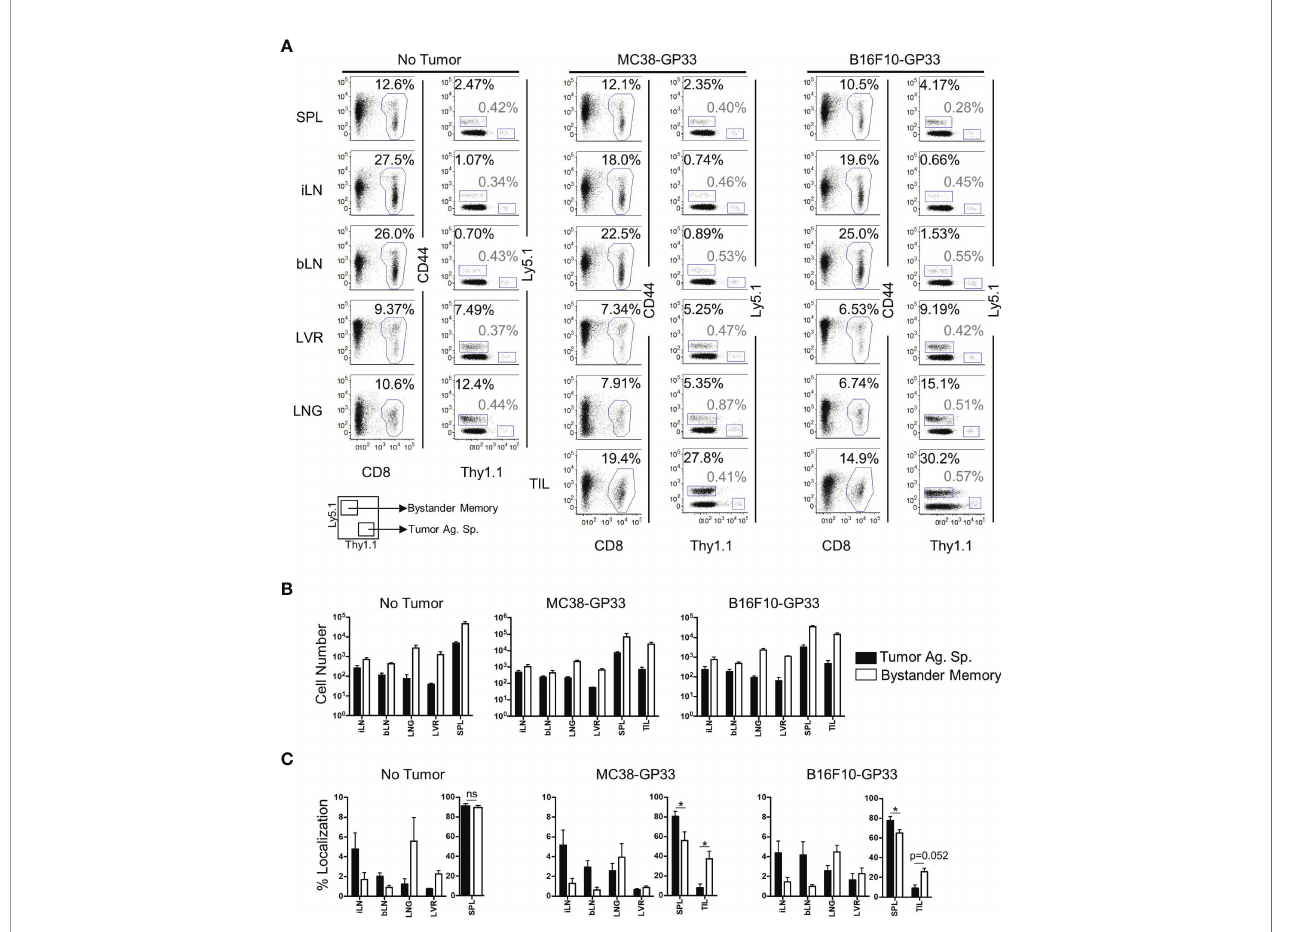
FIGURE 1 | Bystander Memory T Cells in fi ltrate into established solid tumors. WT OT-I CD8 T cells were adoptively transferred into C57BL6 mice and infected with LM-Ova. Following memory differentiation (>day 30 post infection), naïve P14 CD8 T cells were transferred into the mice. The mice were then subcutaneously injected with MC38-GP33 or B16.F10-GP33 tumor cells. (A) FACS plots of CD8 T cells in spleen (SPL), brachial lymph node (bLN), inguinal lymph node, (iLN), liver (LVR), lung (LNG), and tumor in fi ltrating lymphocytes (TIL) show the frequency of donor CD8 T cells of total CD8 T cells or the frequency of bystander memory OT-I donors (black) and tumor antigen speci fi c P14 donors (gray) of total CD8 T cells at day 21 post tumor injection. Bar graphs show (B) the total number of CD8 T cells, bystander memory, and tumor antigen speci fi c T cells in each tissue and (C) the percent localization of bystander memory cells and tumor antigen speci fi c CD8 T cells in each tissue. Percent localization was calculated as total number of speci fi ed cell population in a given tissue divided by sum of that cell population identi fi ed in all the tissues collected. Representative plots are shown from N=5 mice. Signi fi cance was determined by paired T-test. *p < 005. Differences were non-signi fi cant if not otherwise indicated. Data is representative of 3 separate experiments. ns, non-signi fi